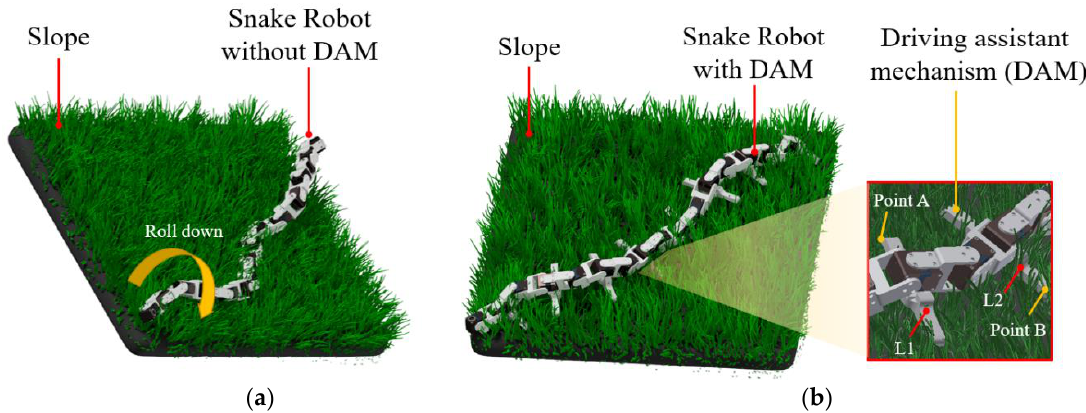
Figure 1. Conceptual diagram for locomotion of a snake robot ( a ) without a driving assistant mechanism (DAM) and ( b ) with a DAM.